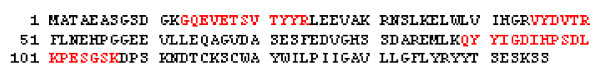
Mass-Spectrometry data of protein isolated by 2D-gel electrophoresis. The protein was cleaved by Trypsin from C-term side of KR unless next residue is P. Matched peptides are shown in Bold Red and sequence coverage is 25%.